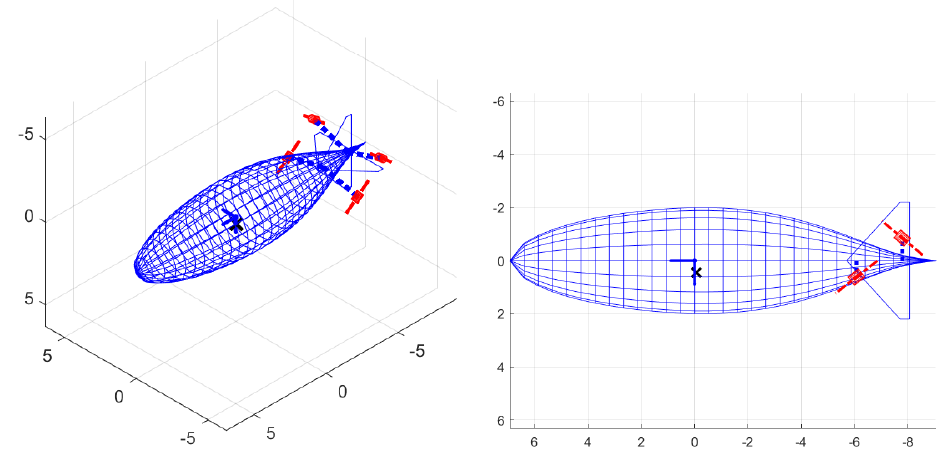
Figure 3. Conceptual layout of a four-thrusters airship with no movable surfaces and no thrust vector control. ( Left ) three-quarters view. ( Right ) view from the port side of the